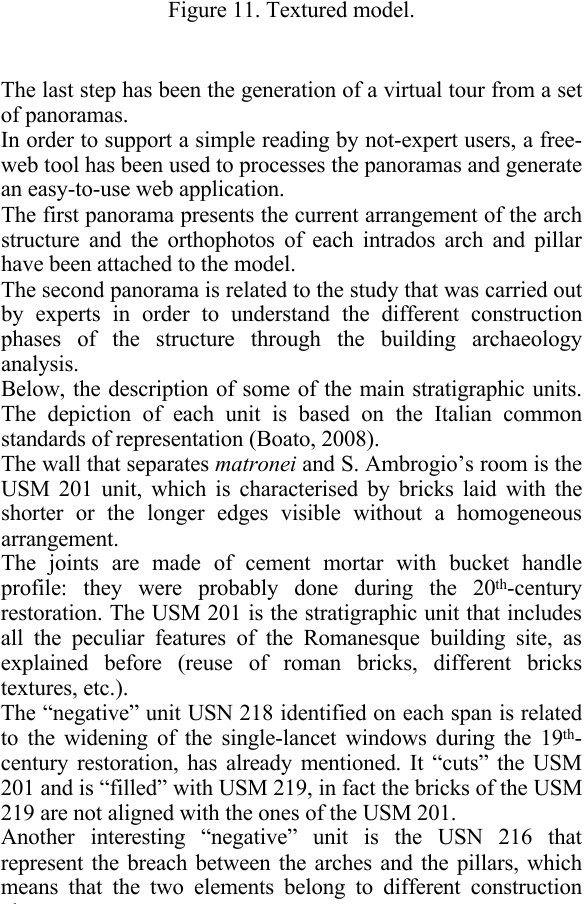
Figure 11. Textured model.